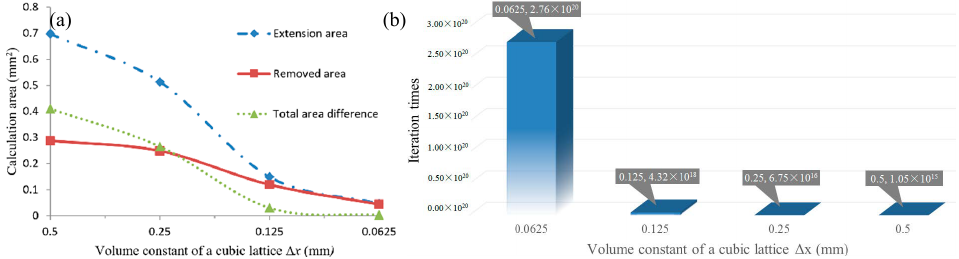
Figure 3. Geometric model of the CCMTT: ( a ) 3D model of the CCMTT and ( b ) geometric shape and key parameters of the CCMTT.